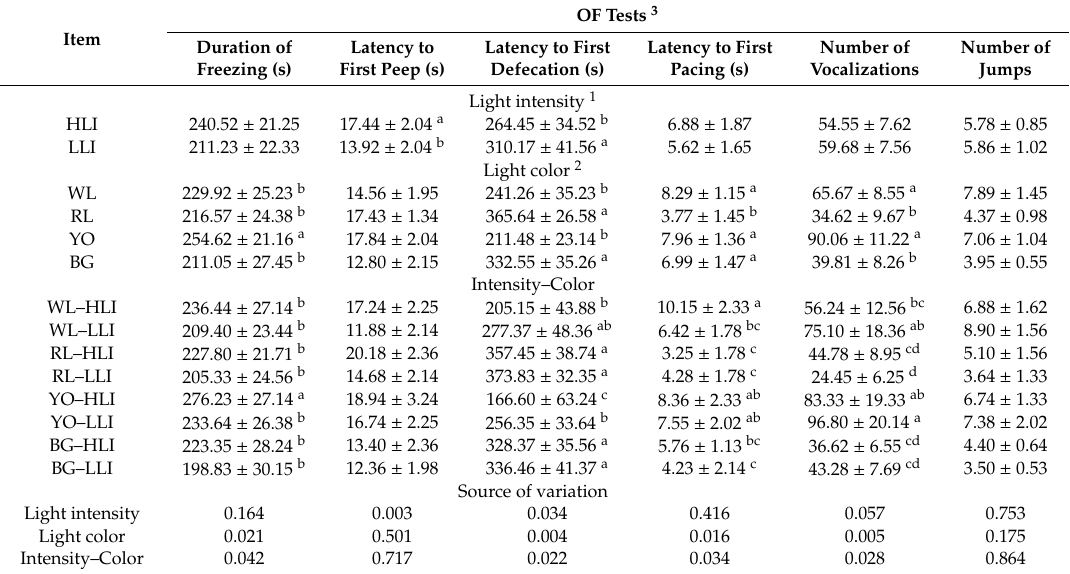
Table 3. Means ( ± SE) of responses of hens to the OF test in response to light colors and light intensities *. Item